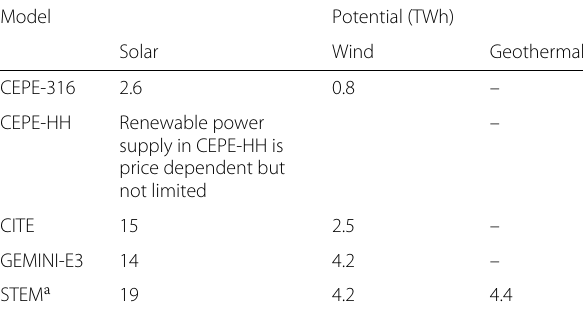
Table 6 Renewable